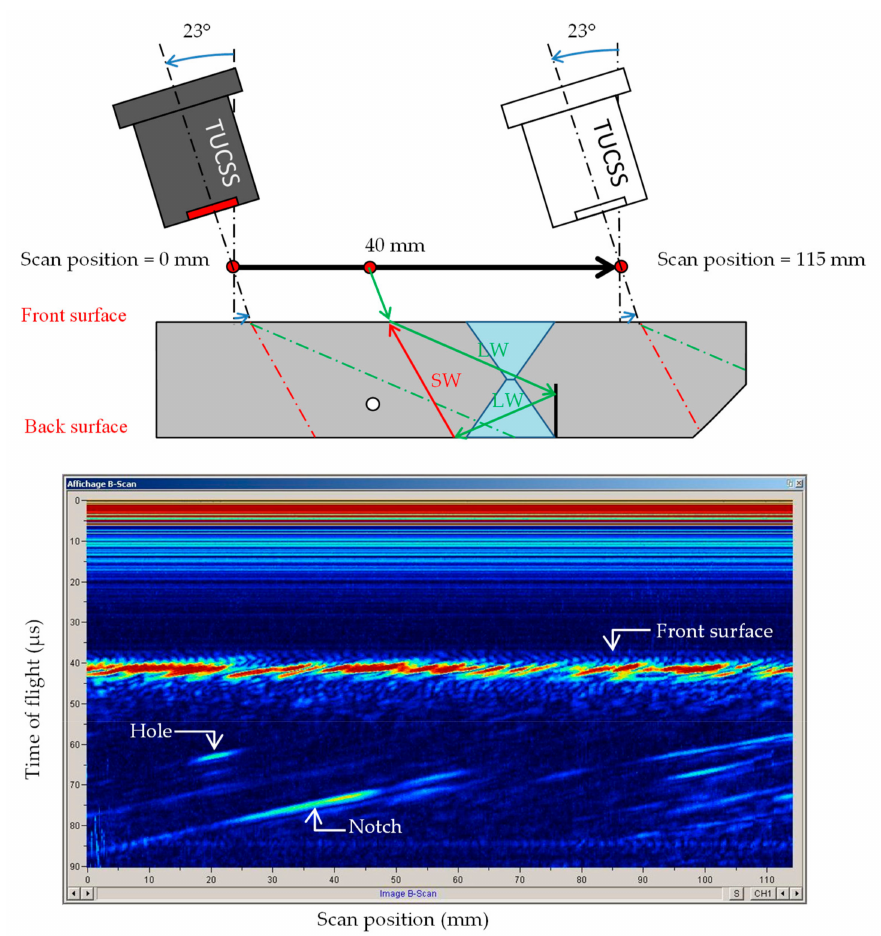
Figure 8. Scan at an incidence of 23 ◦ , generating LW65 ◦ and SW29 ◦ in the